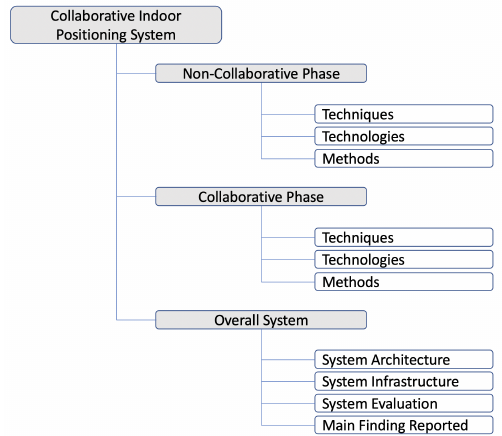
Figure 3. Structure of classification of